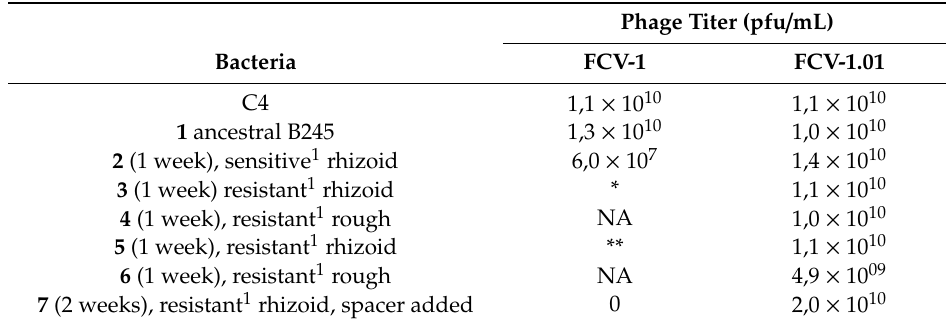
Table 1. Titers (PFU / mL) of ancestral FCV-1 and evolved FCV-1.01 on selected isolates (number in bold before strain corresponds the bacterial strains marked in Figure 3).